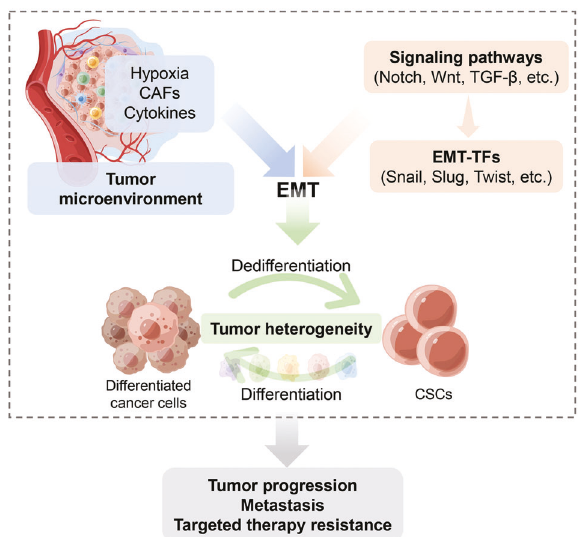
Fig. 3 Mechanisms driving tumor cell plasticity and drug resistance. Both tumor microenvironment factors and EMT-related signaling pathways regulate the EMT process. The activation of EMT facilitates the dedifferentiation of non-cancer stem cells (CSCs) to CSC, which contributies to tumor